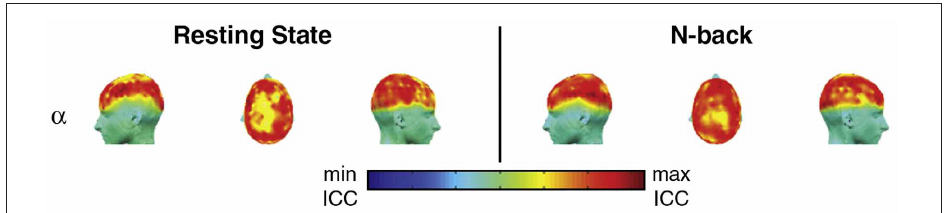
FIGURE 2 | Reliability (ICC) of network efficiency on a nodal (sensor) level, for the α -band. While ICC scores were generally low and high during the resting state and n -back working memory task, respectively, reproducibility showed spatial variation across the brain. This image was adapted from Deuker et al.